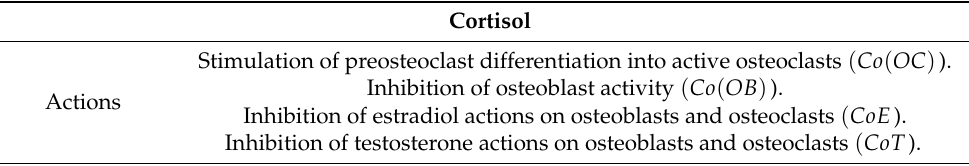
Table 5. Cortisol actions and their mathematical formulation.